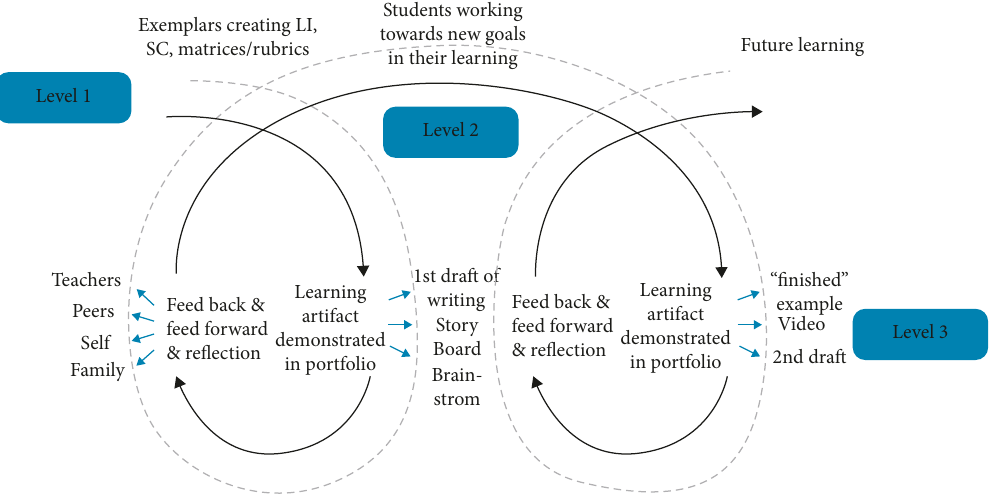
Figure 1: E-portfolios and formative assessment adapted from EUfolio [12].